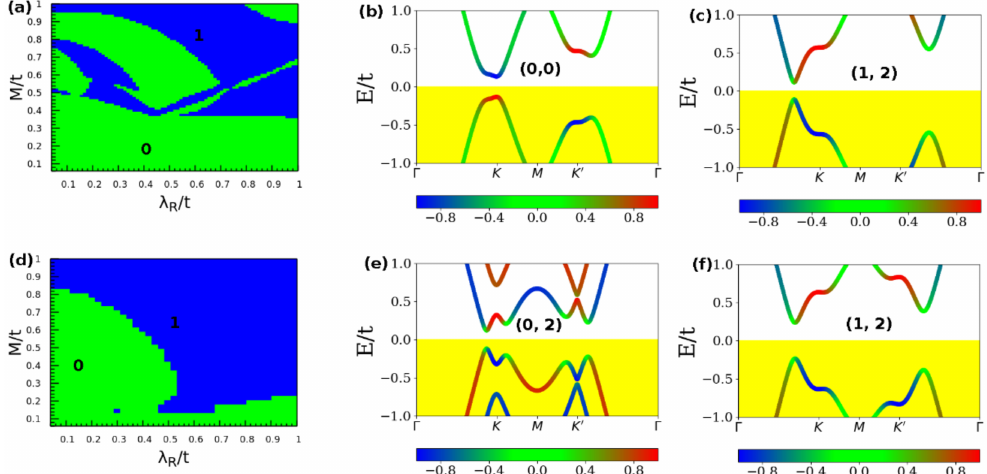
Figure 2. Effect of a fixed staggered sublattice potential of 0.1 t on the topological invariant phase diagram of the Haldane model on the modified honeycomb lattice ( a ). The associated band structure of identified electronic phases in phase fields is indicated by the blue color ( b ) and green ( c ). A similar plot at a fixed staggered sublattice potential of 0.3 t ( d ) and the band structures are associated with the two-phase regions denoted by color blue ( e ), and green ( f ). The color bars in ( b , c ) and ( e , f ) denote the expectation value of the spin texture in units of S Z , where ¯ h =